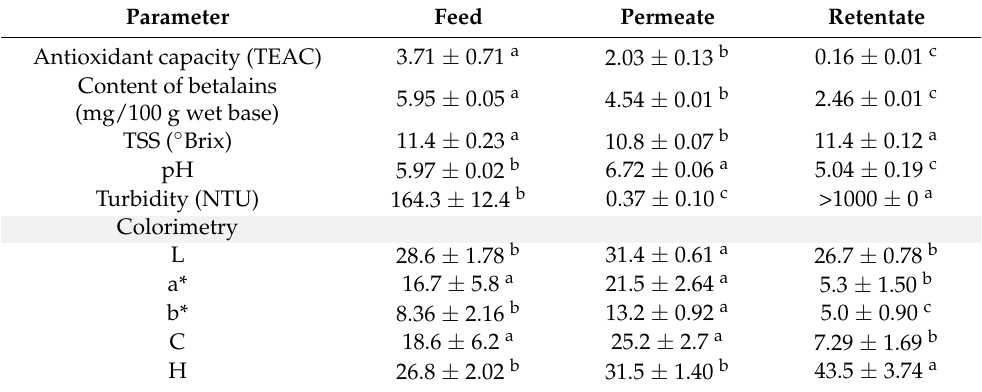
Table 3. Physicochemical properties of the juice before and after the clarification